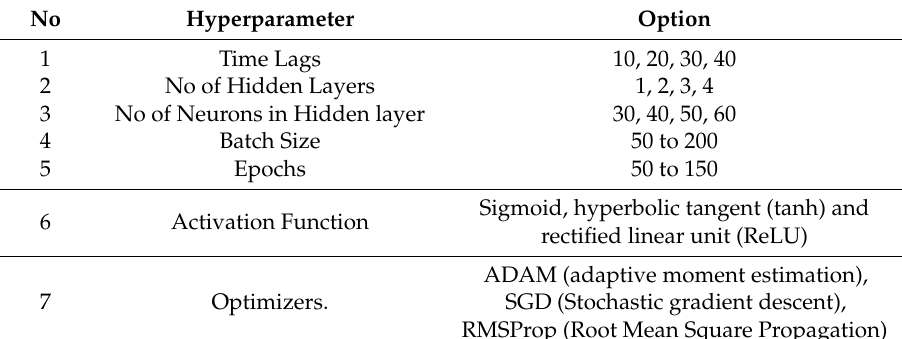
Table 2. Hyperparameters testing for experiment.